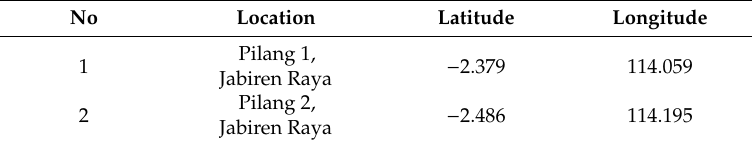
Table 2. Location and coordinate of WT depth real-time monitoring station used in the research. No Location Latitude